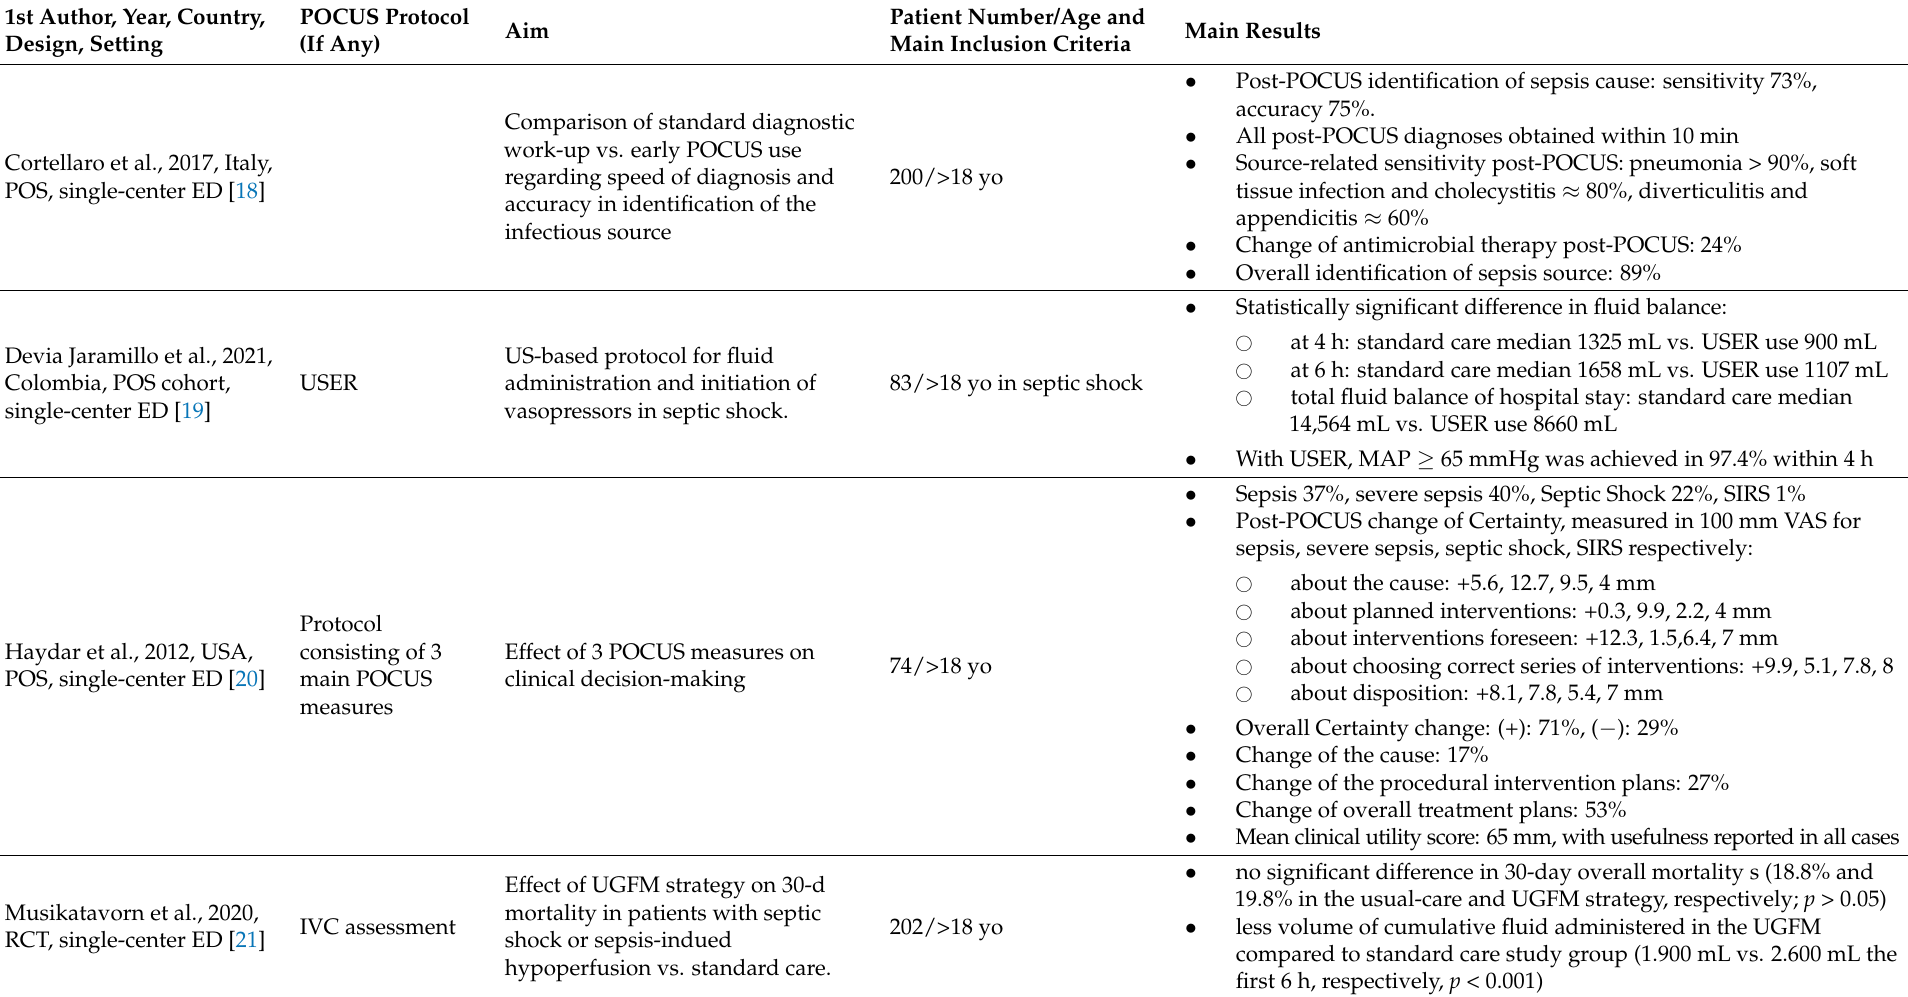
Table 2. Studies examining the utility of POCUS in identifying the source of sepsis, as well as guiding and managing septic patients